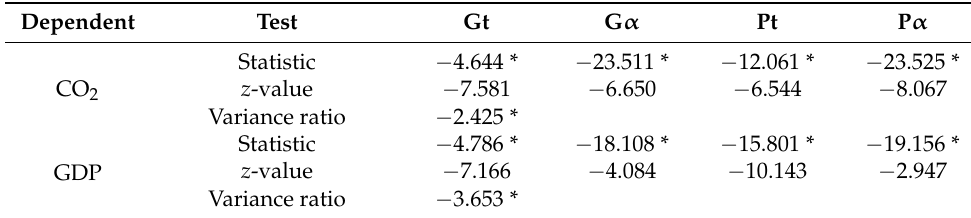
Table 6. Westerlund error correction term (ECT) panel cointegration test results.